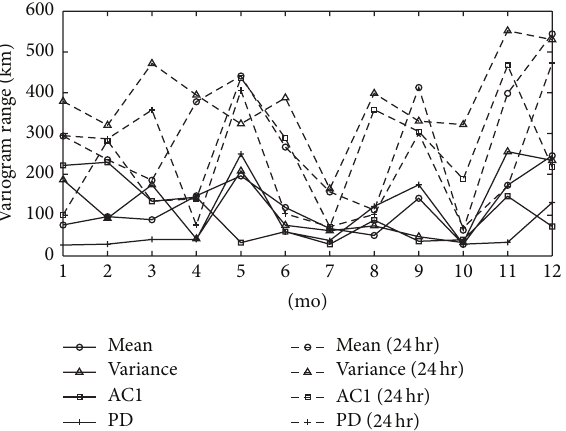
Figure 13: Monthly variation of the model variogram range of the precipitation mean, variance, AC1, and PD of hourly and daily precipitation of Korean